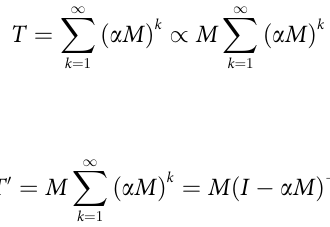
S1 Fig. Average value of metabolites with standard deviation determined in CSF samples determined from 1D NOESY measurements. Shown are values prior to